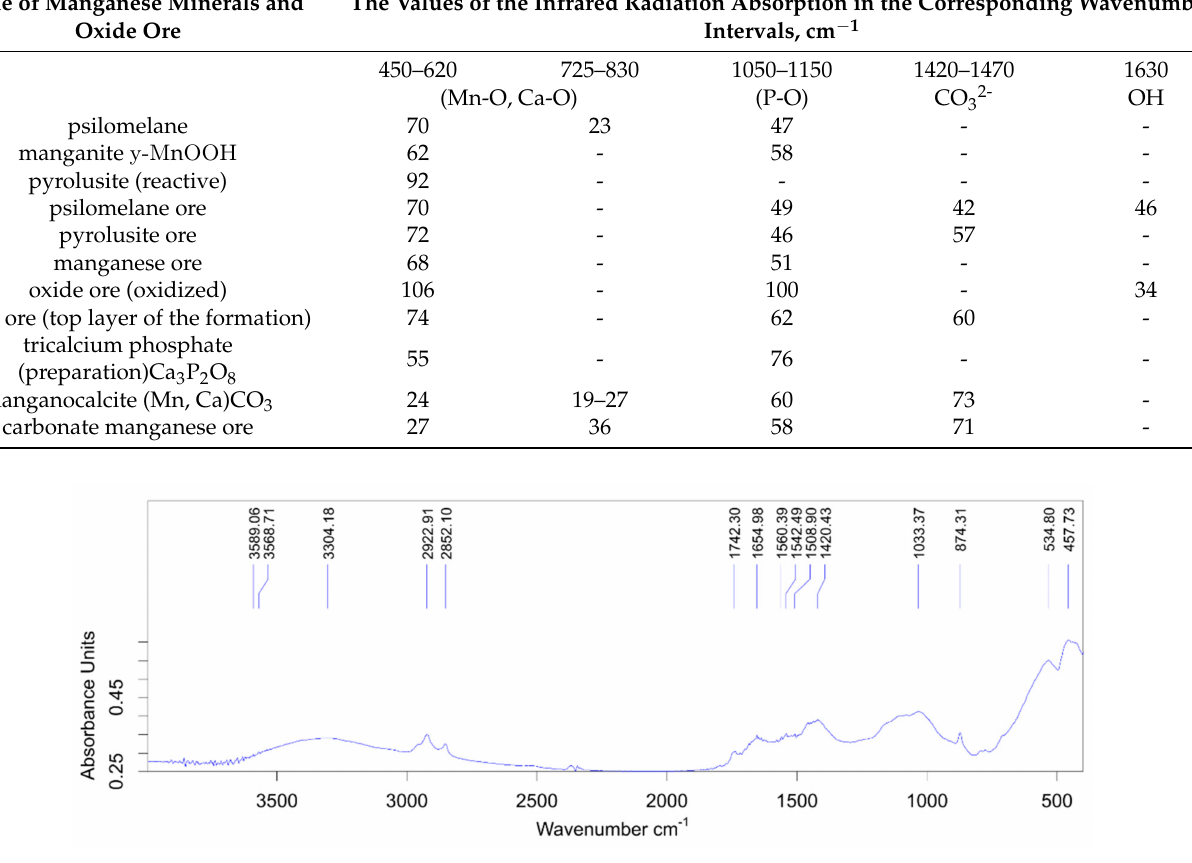
Figure 10. The infrared absorption spectrum of manganese ore from the Bogach